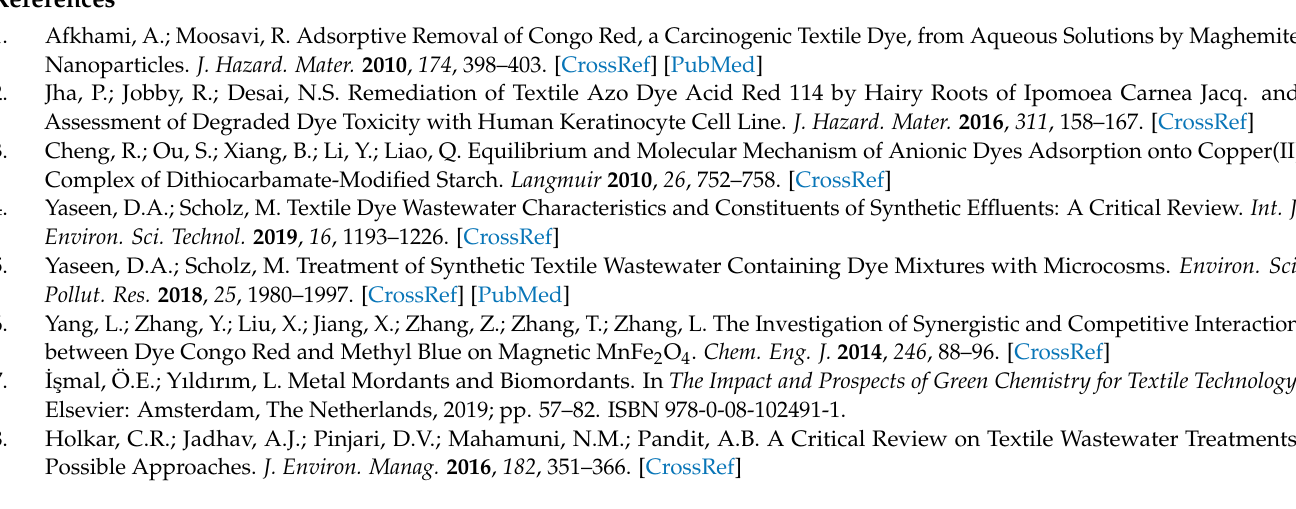
Table S1: Kinetic parameters of CR, MB or Pb(II) adsorption onto the HC–MgAlLDH; Table S2: Adsorption isothermal parameters of CR, MB and Pb(II) by the HC–MgAlLDH nanocomposite in various systems; Table S3: Comparison of the Langmuir removal capacities ( q m ) of various LDH- based adsorbents to single CR, MB and Pb(II); Figure S1: SEM images and EDS analyses of the synthesized MgAlLDH (a) and HC (b); Figure S2: The species distribution of Pb(II) in aqueous solution (50 mg/L Pb(II)), calculated by a chemical equilibrium program Visual MINTEQ (version 3.1); Figure S3: Recycle test for the removal of CR, MB and Pb(II) by HC–MgAlLDH nanocomposite; Figure S4: SEM images of regenerated HC–MgAlLDH nanocomposite after treatment of CR (a), MB (b) and Pb(II) (c); Figure S5: XRD patterns of regenerated HC–MgAlLDH nanocomposite after treatment of CR (a), MB (b) or Pb(II)